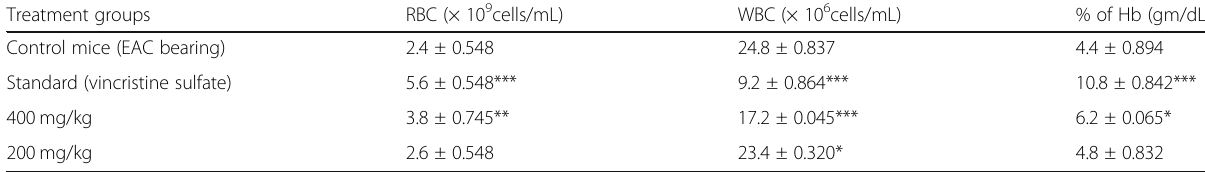
Table 1 Effect of Chenopodium album leaf extract on EAC cell bearing Swiss albino mice to restore all the biochemical parameters after 6 days of treatment Treatment